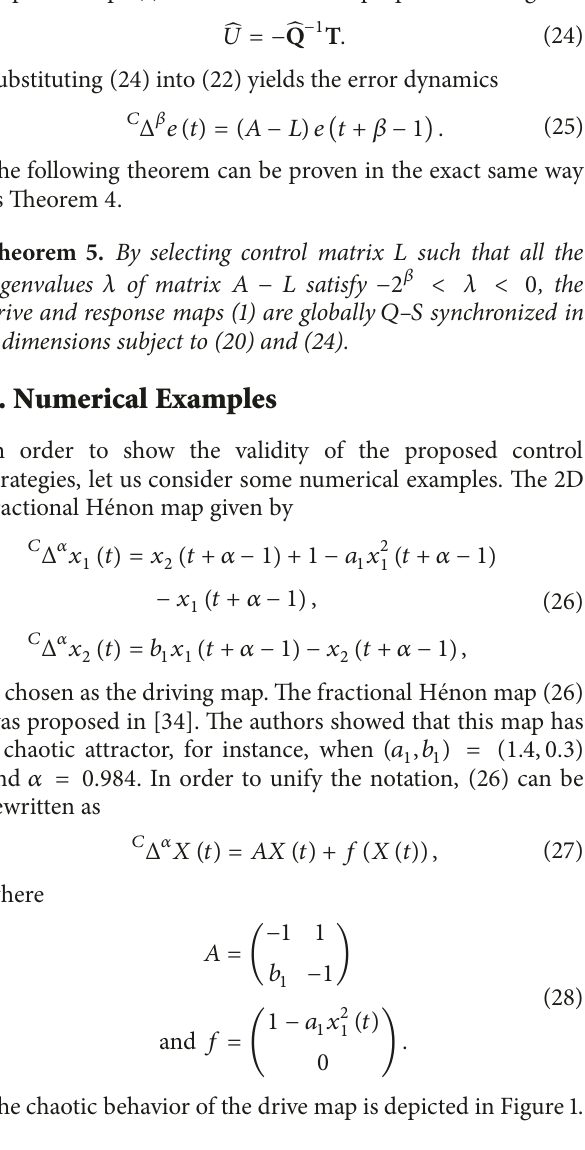
−0.5−0.4−0.3−0.2−0.100.10.20.30.4 x 2 Figure 1: Phase space plot for the fractional H´enon map with (𝑎 , 𝑏 ) = (1.4, 0.3) , 𝛼 = 0.984 , and 𝑥 1 1